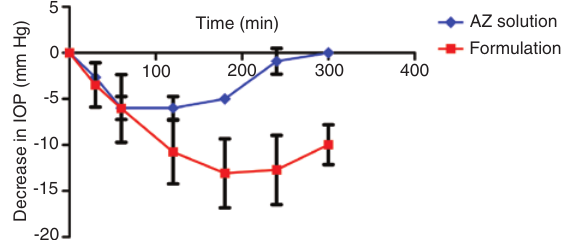
Figure 8: Ocular hypotensive activity of AZ from the aqueous solu- tion and optimized CS